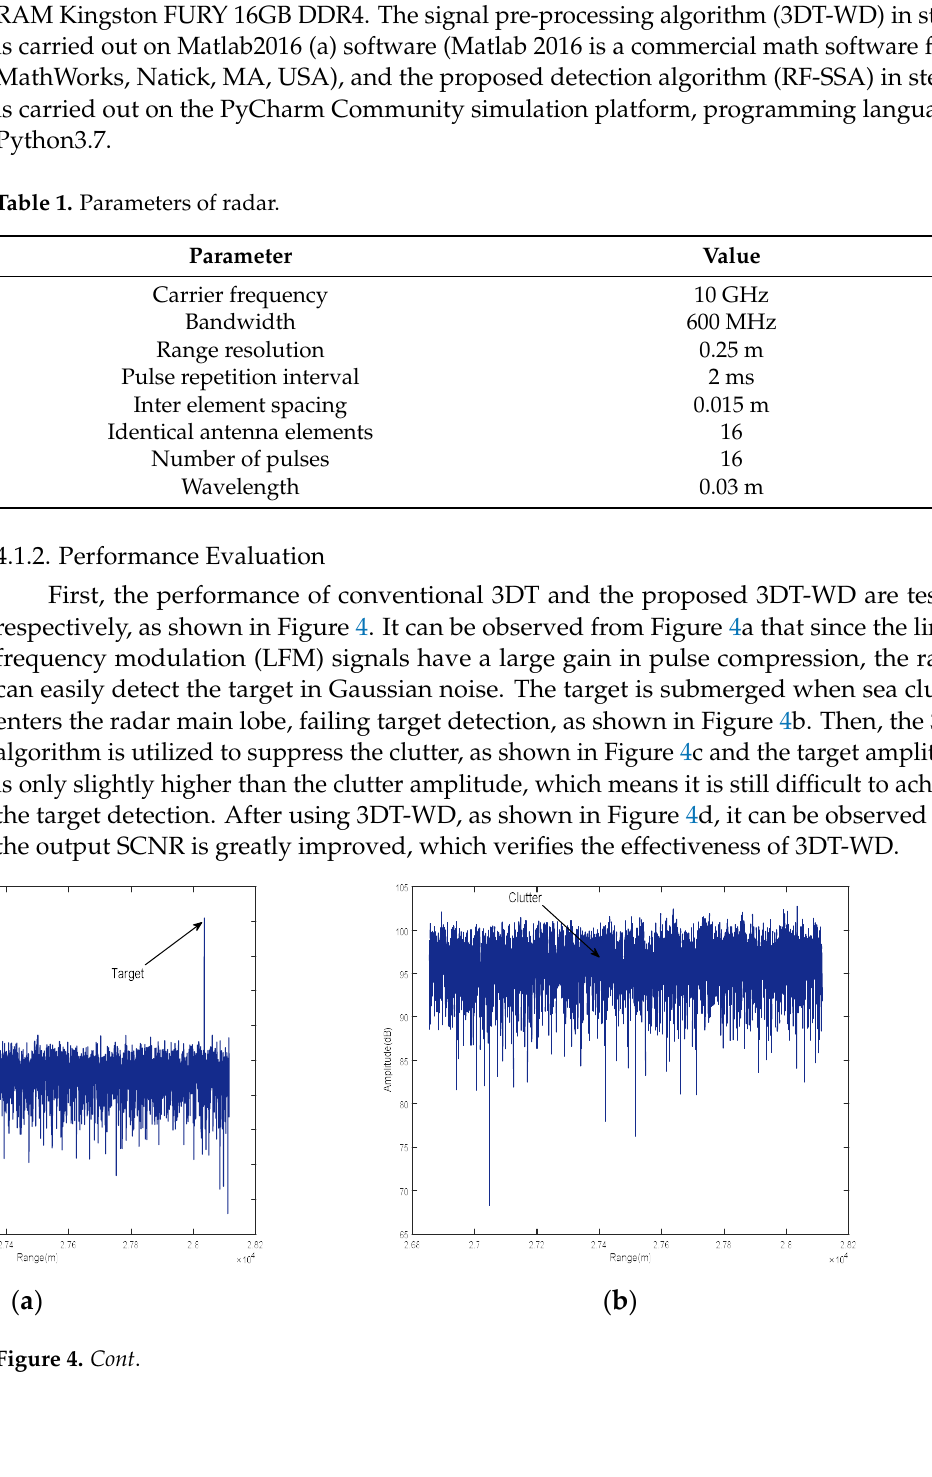
Table 1. Parameters of radar.